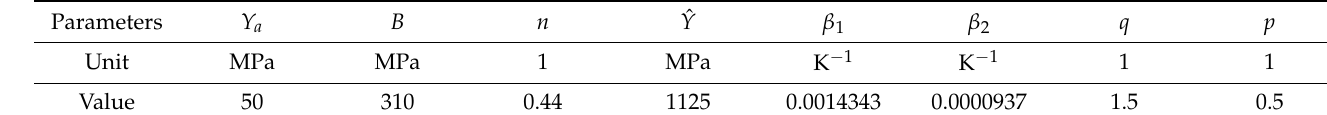
. ε ∗ = 1 s − 1 , T m = 3290 K) [19]. Table 9. Parameters of the VA model for tantalum ( 𝜀(cid:4662) ∗ = 1 s − 1 , T m = 3290 K) [19].